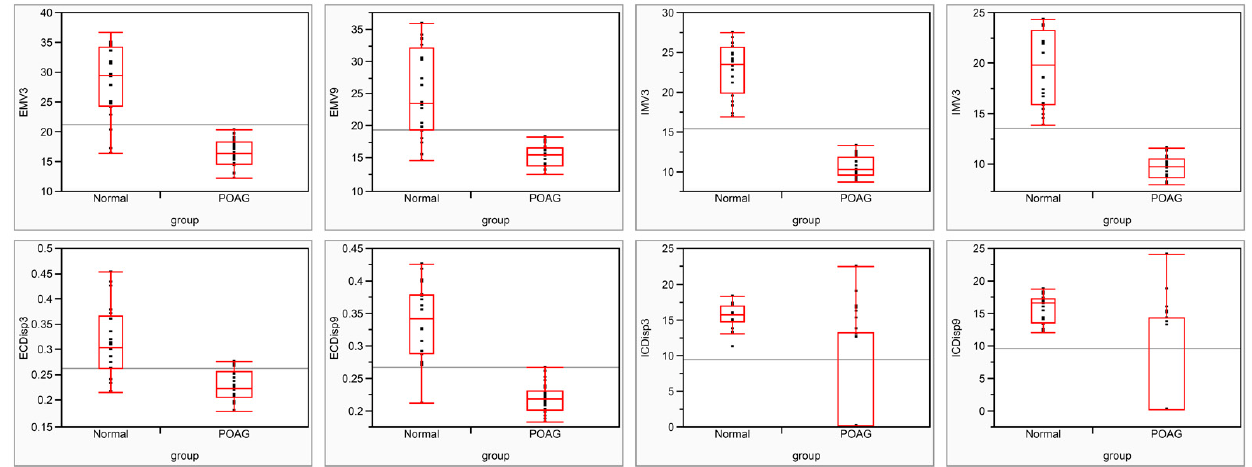
Figure 3. The pulsatile trabecular meshwork (TM) motion in normal and POAG eyes. MV—maximum velocity; CDisp—cumulative displacement; EMV3—MV in the external region of TM in the nasal area; EMV9—MV in the external region of TM in the temporal area; IMV3—MV in the internal region of TM in the nasal area; IMV9—MV in the internal region of TM in the nasal area; ECDisp3—CDisp in the external region of TM in the nasal area; ECDisp9—CDisp in the external region of TM in the temporal area; ICDisp3—CDisp in the external region of TM in the nasal area; ICDisp9—CDisp in the external region of TM in the temporal area. POAG—primary open-angle glaucoma.